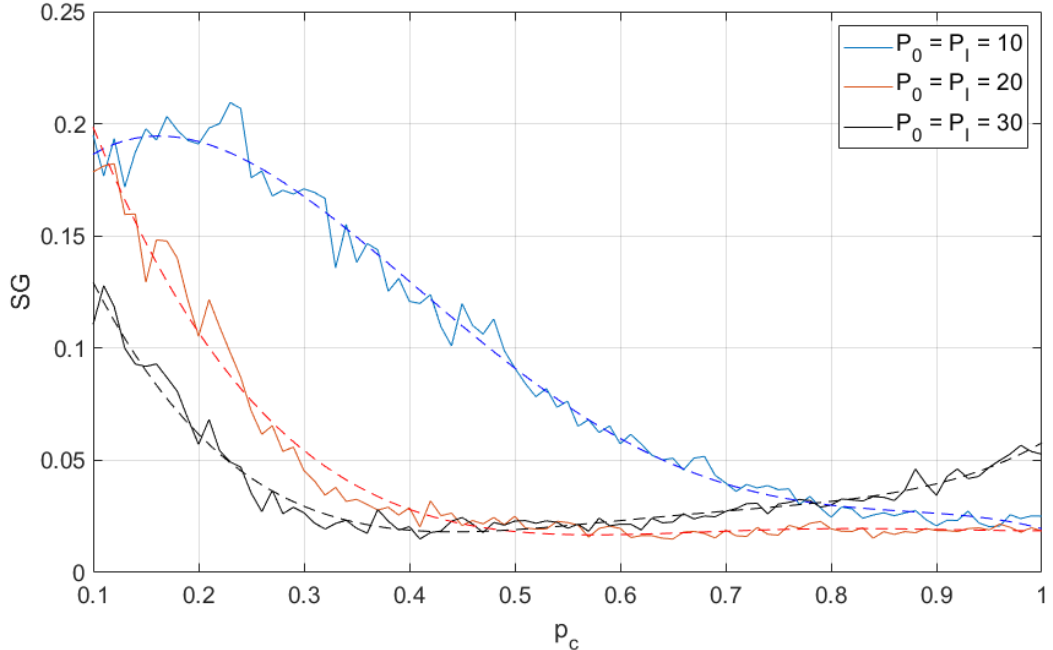
Figure 4. Second largest cluster size as function of node operation probability (different transmit power levels); 100 neuron-nodes. Dashed lines are a fourth-degree polynomial